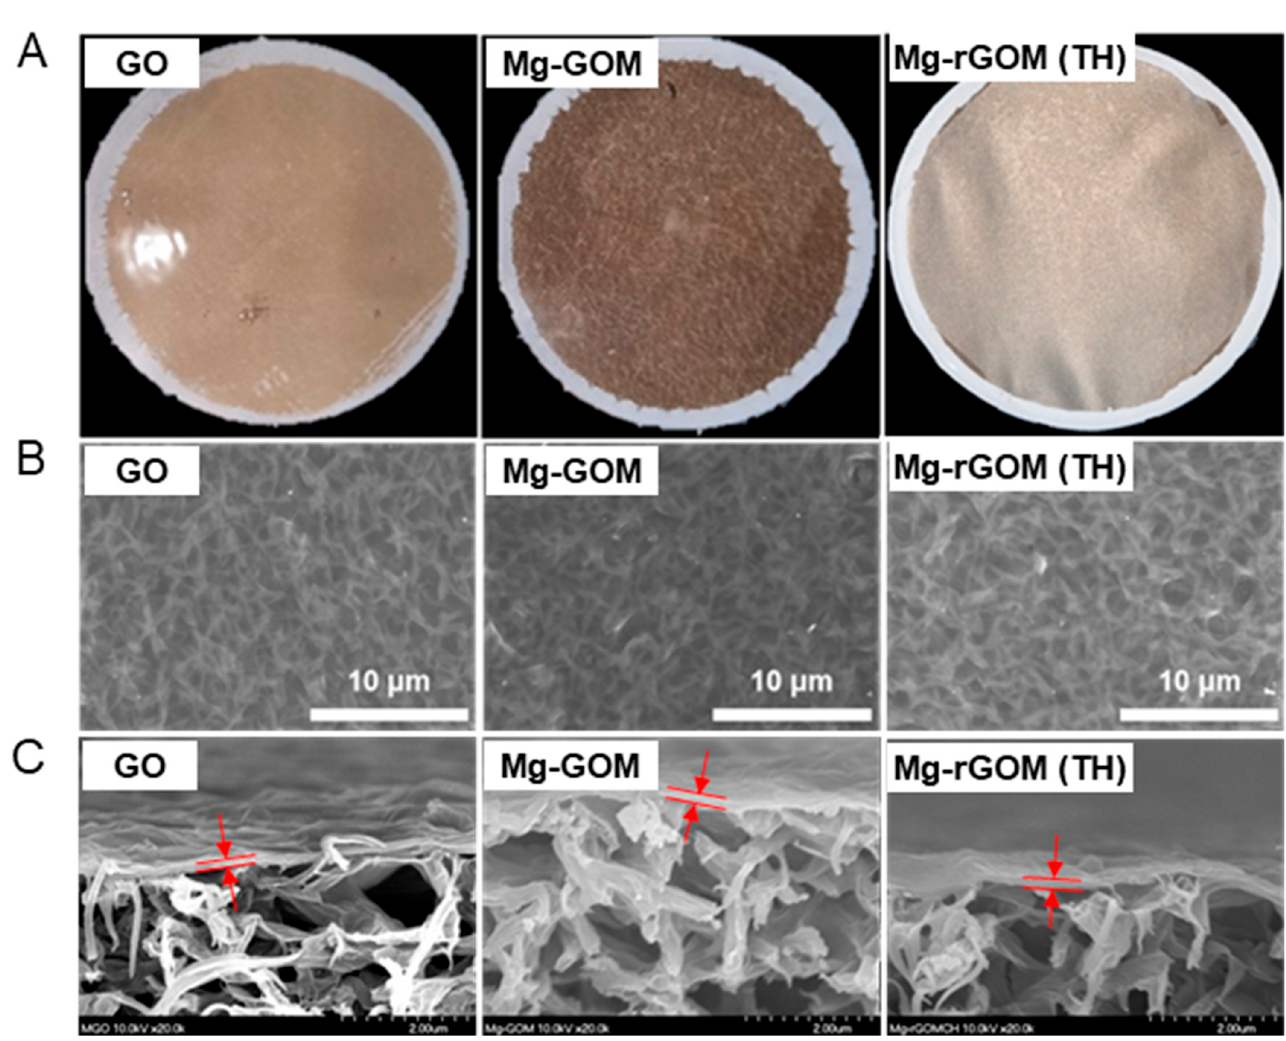
Figure 2. ( A ) Photographs, ( B ) top-view SEM images, and ( C ) cross-sectional SEM images of GOM, Mg-GOM, and Mg-rGOM(TH).